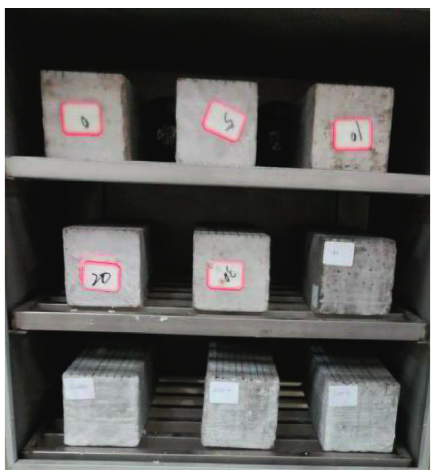
Figure 3: Specimen placement